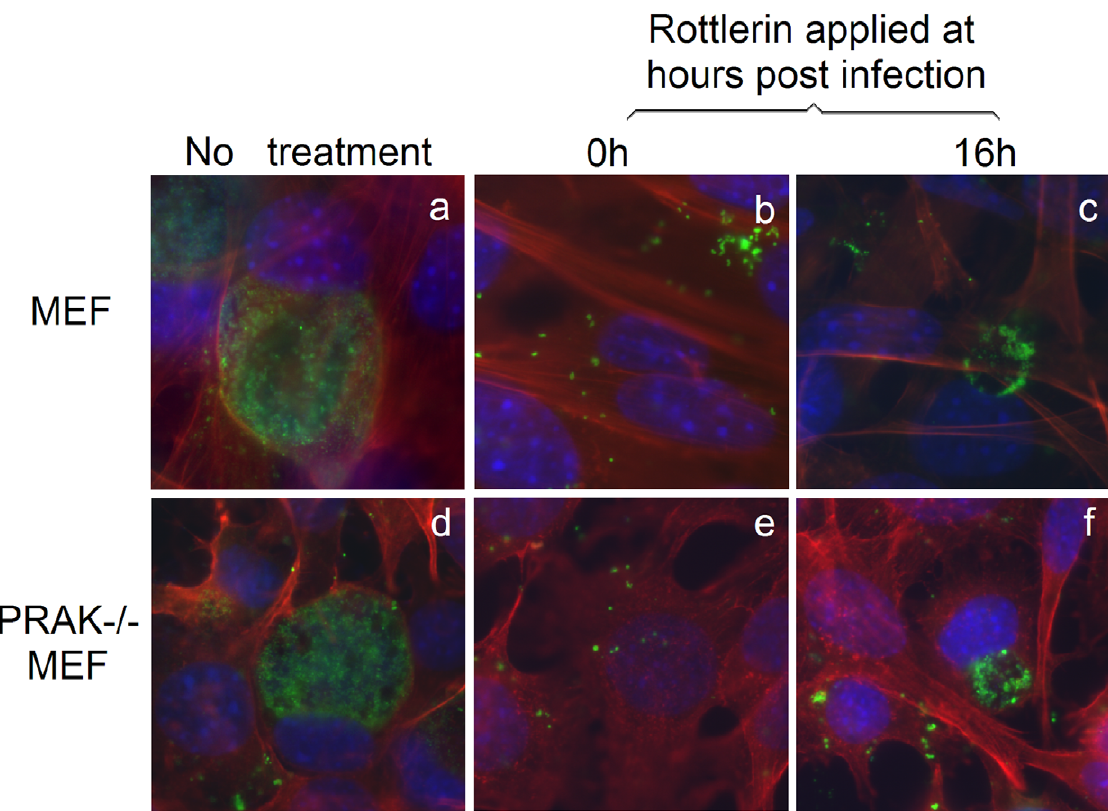
Figure 4. Rottlerin inhibits chlamydial growth in the absence of PRAK. MEF without (panels a–c) or with (d–f) PRAK deficiency (PRAK 2 / 2 ) were infected with C. trachomatis (MOI=0.5) and at oh (b & e) or 16 h (c & f) post infection, parallel cultures were treated with (b, c, e & f) or without (a & d) rottlerin at 1 m M. The cultures were processed 44 h post infection for immunofluorescence assay as described in Fig. 3 legend. Note that rottlerin inhibited chlamydial growth in both wild type and PRAK-deficient MEF cells.